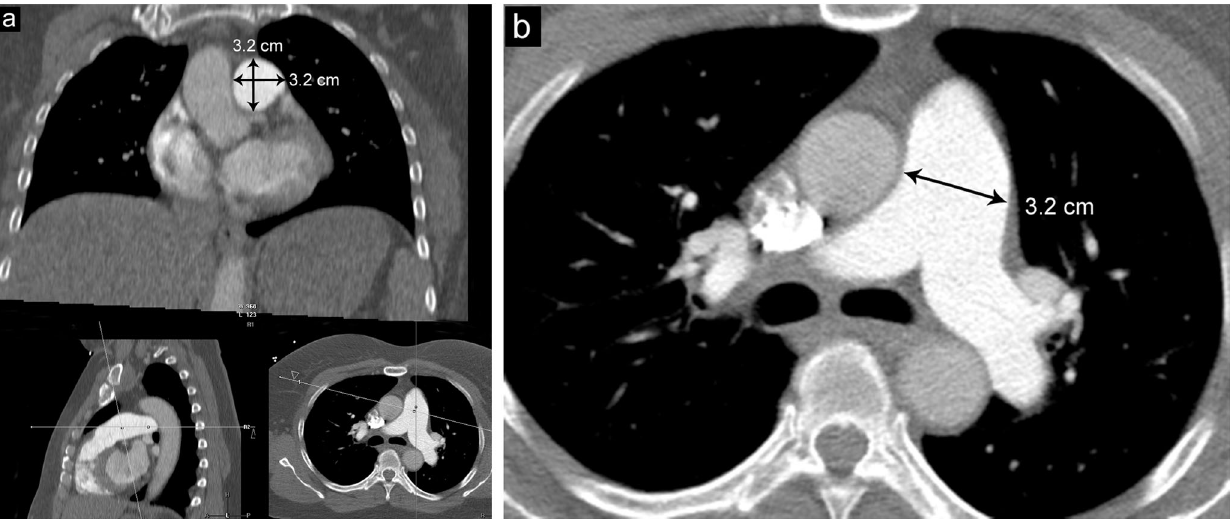
Fig. 4 Pulmonary artery measurement. a CTimaging demonstrating double oblique measurement technique through the main pulmonary artery. b Axial CT image demonstrating transverse measurement through the main pulmonary artery at the level of the right pulmonary artery